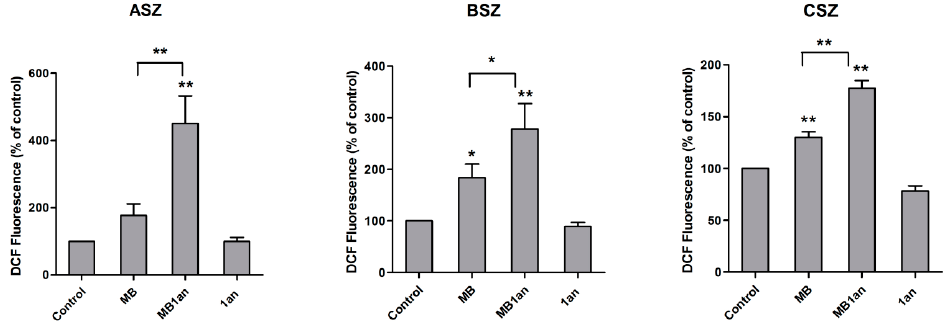
Figure 6. Reactive oxygen species production in ASZ, BSZ, and CSZ cell lines upon irradiation and incubation with MB, MB-1an and 1an presented as DCF fluorescence (% of control). The concentration of MB was 5 µM and the 1an concentration was 1 µM. * p < 0.05, ** p < 0.001.